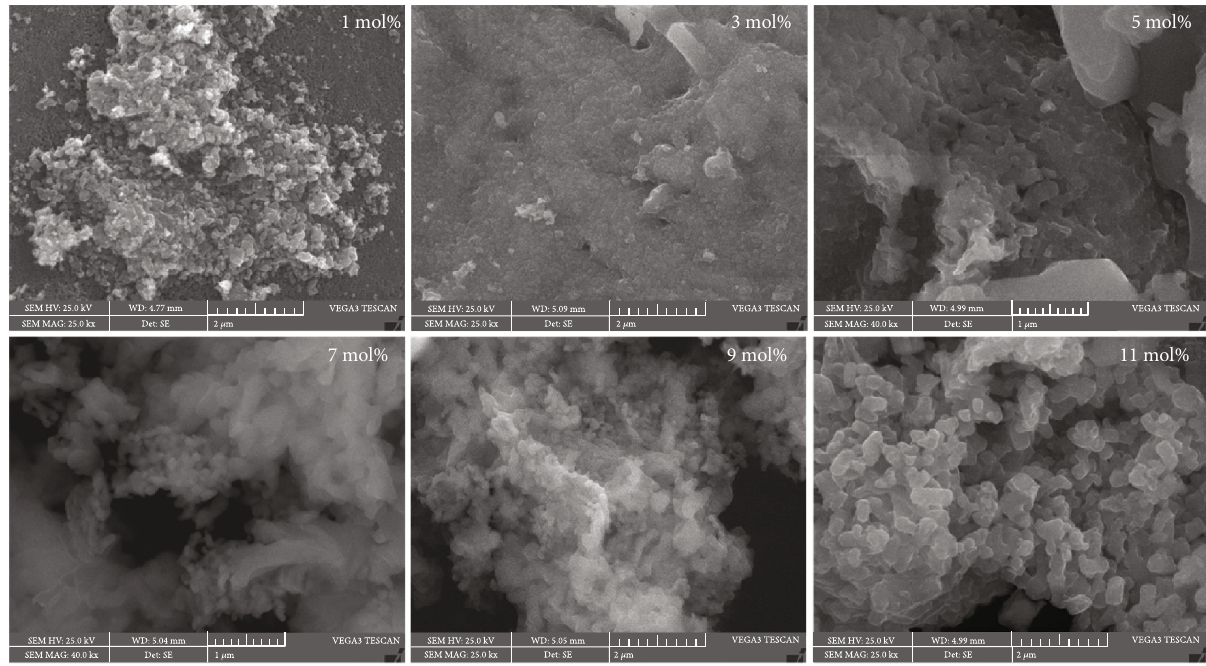
Figure 3: SEM images of ZrO